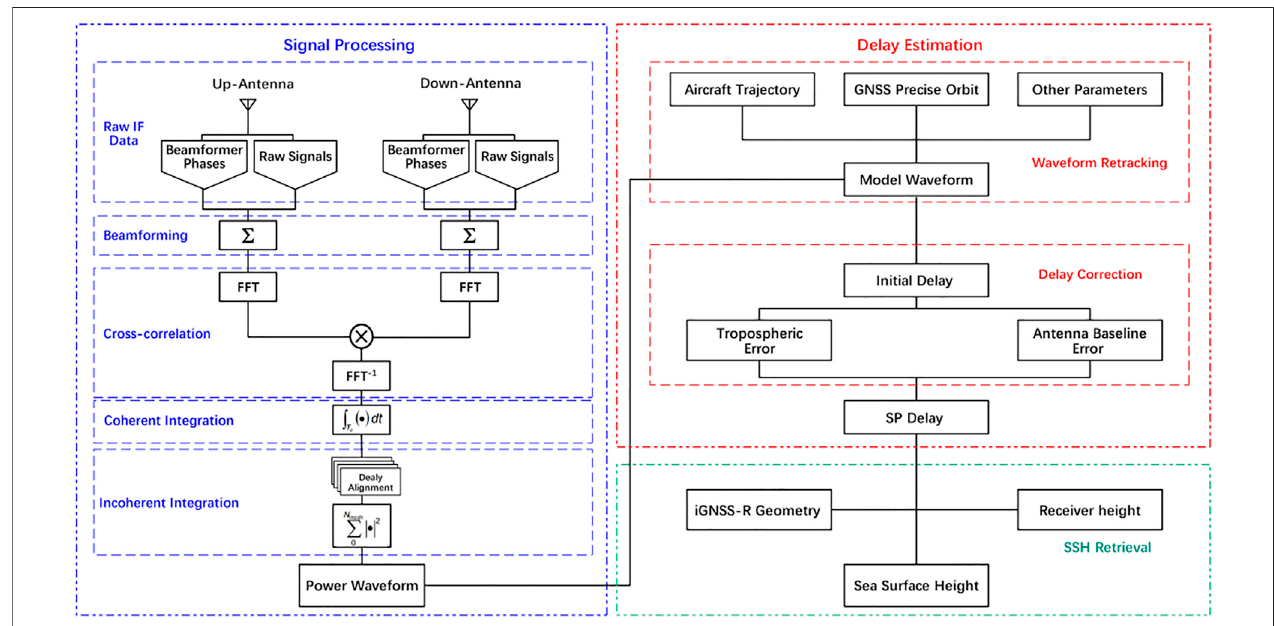
FIGURE 3 | Schematic fl ow chart of the process followed by SSH inversion from raw IF